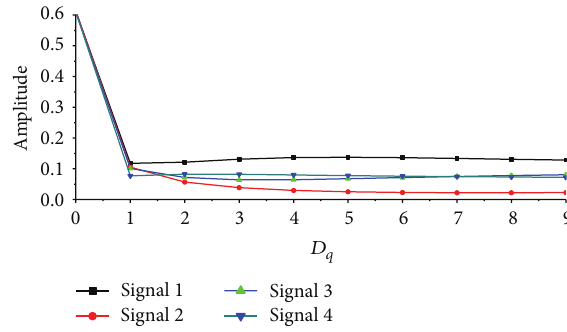
Figure 9: The generalized dimension curve ( 𝐽 = 5 ).